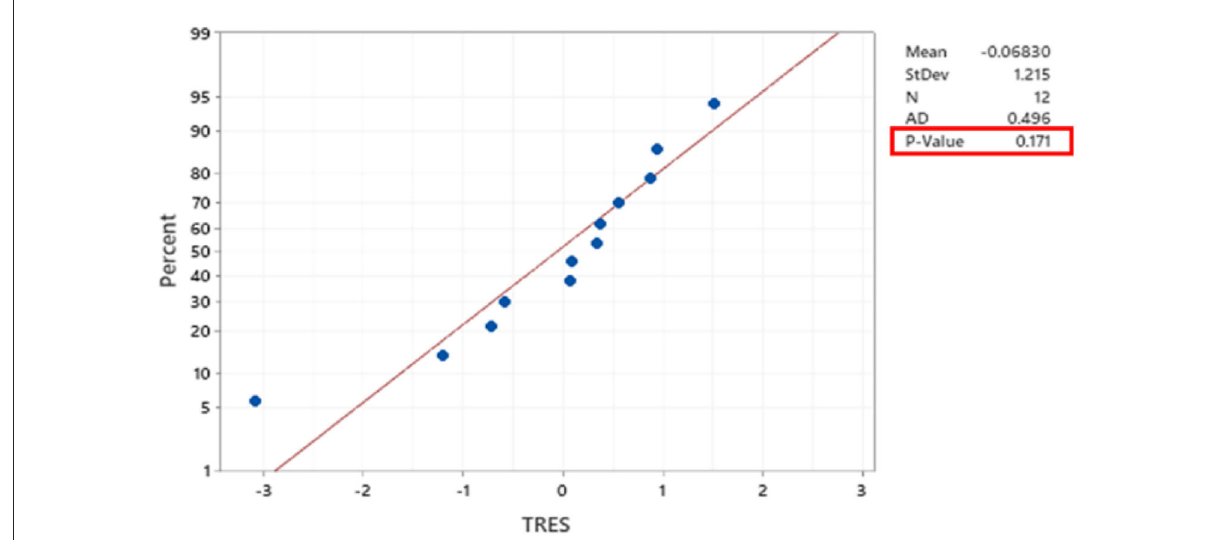
FIGURE3 Normal probability plot of deleted residuals of RSEI (Note: TRES: deleted residuals).